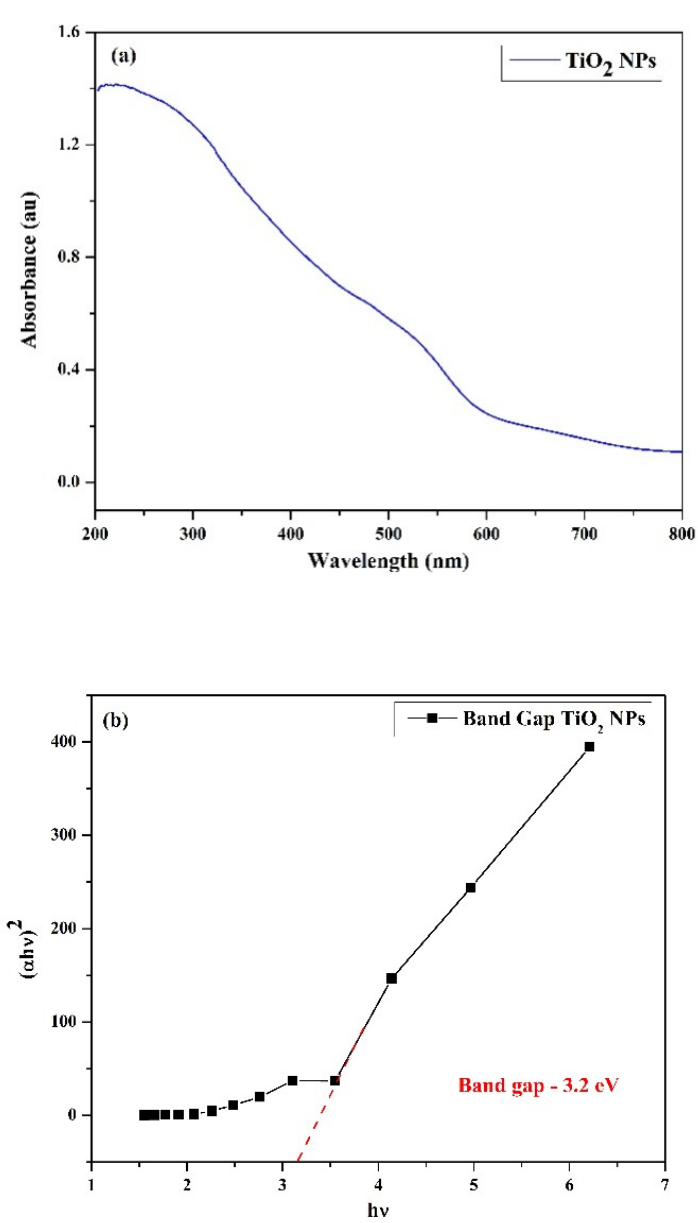
Figure 3. ( a ) UV–DRS spectrophotometric analysis and ( b ) Tauc plot of TiO 2 nanoparticles.